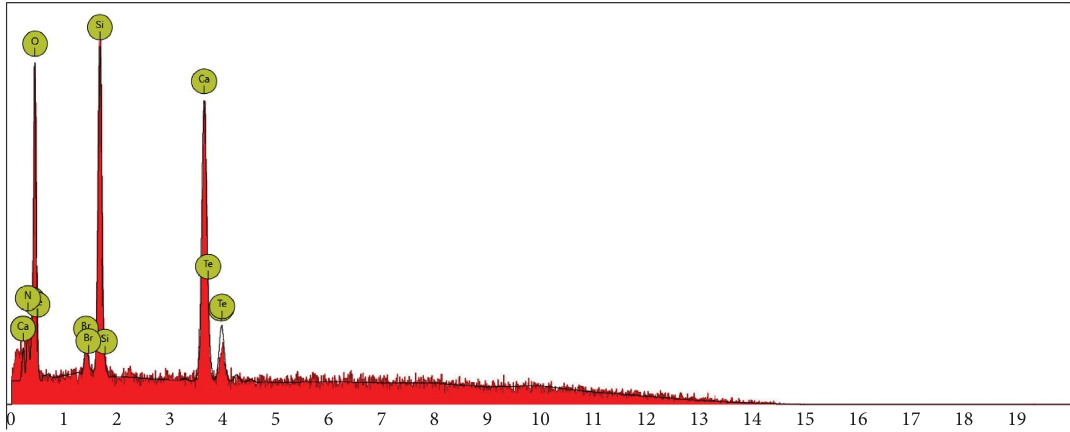
Figure 24: Graphical representation of elements concentration for M1 sample 800 ° C.